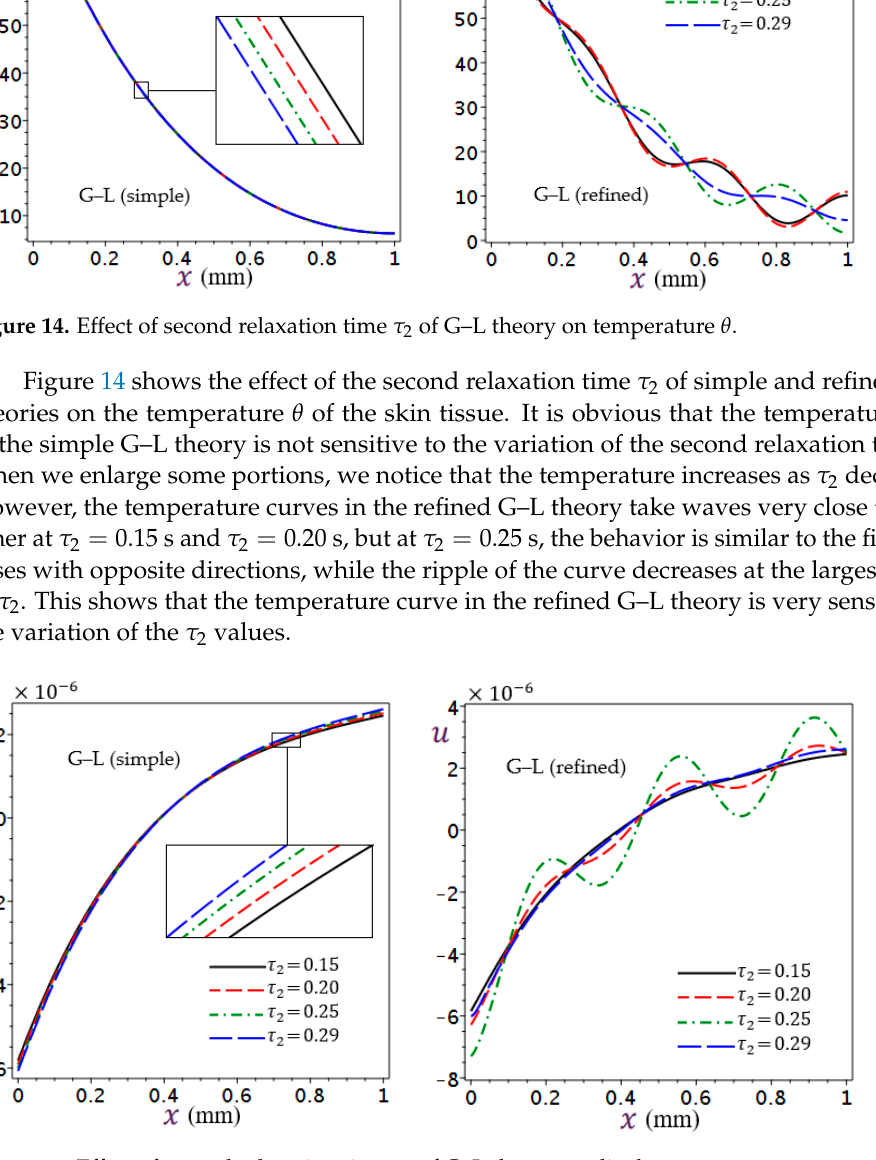
Figure 15. Effect of second relaxation time τ 2 of G–L theory on displacement u .